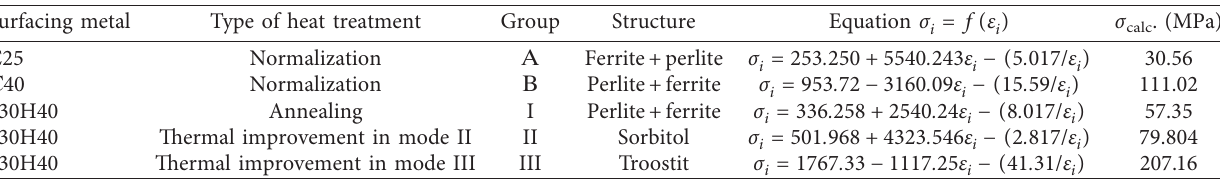
Table 13: Equations that approximate the relationship between stress and total microplastic deformation of the deposited samples after various heat treatments.